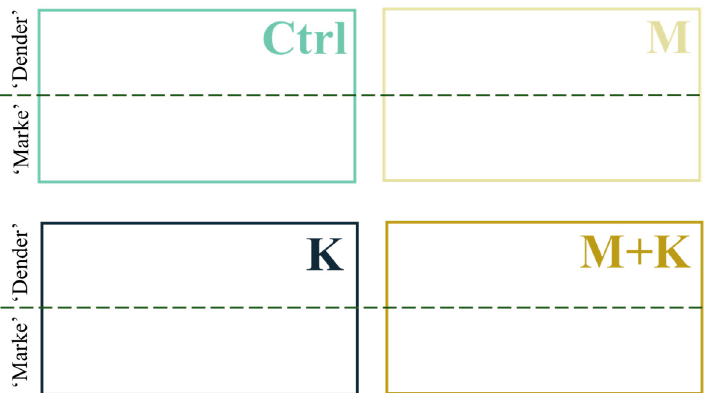
Figure 1. Scheme of inoculation setup using four 10 l containers, filled with tap water, in which the poplar cuttings were inoculated. Ctrl (Control): Non-inoculated cuttings; M: Methylbacterium sp. CP3 inoculation; K: Kineococcus endophyticus CP19 inoculation; M+K: Methylbacterium sp. CP3 and Kineo- coccus endophyticus CP19